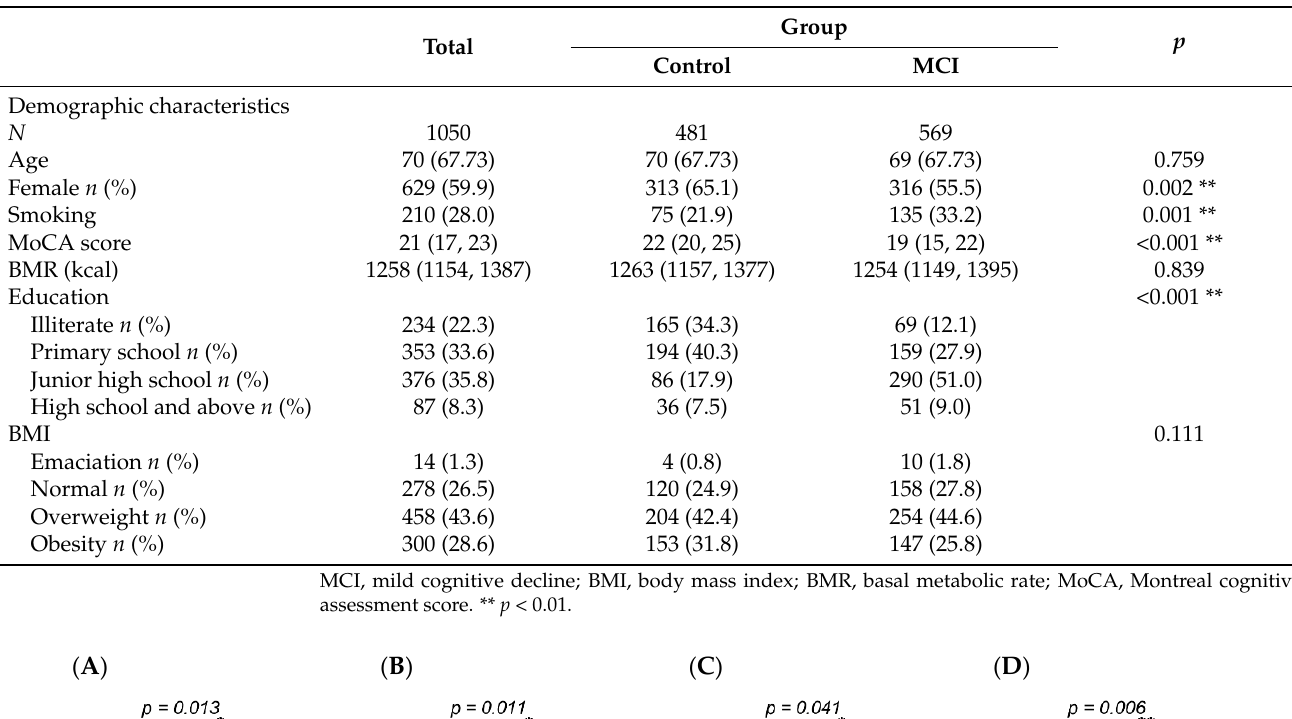
Table 1. Demographic characteristics overall and by MCI.